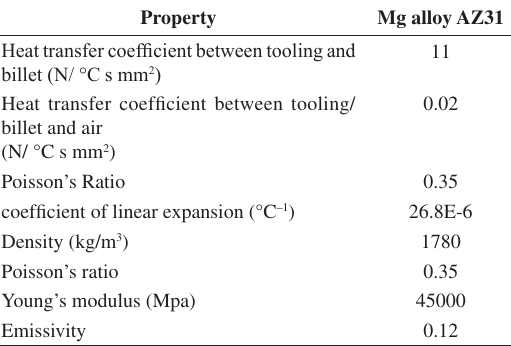
Table 1. Physical properties of the AZ31 workpiece.